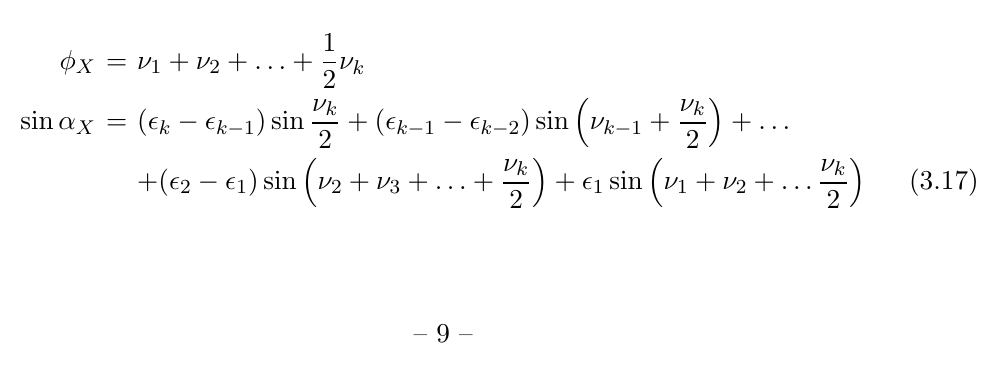
, sin (cid:22) (cid:11) describing antineutrino mixing (see discussion X X